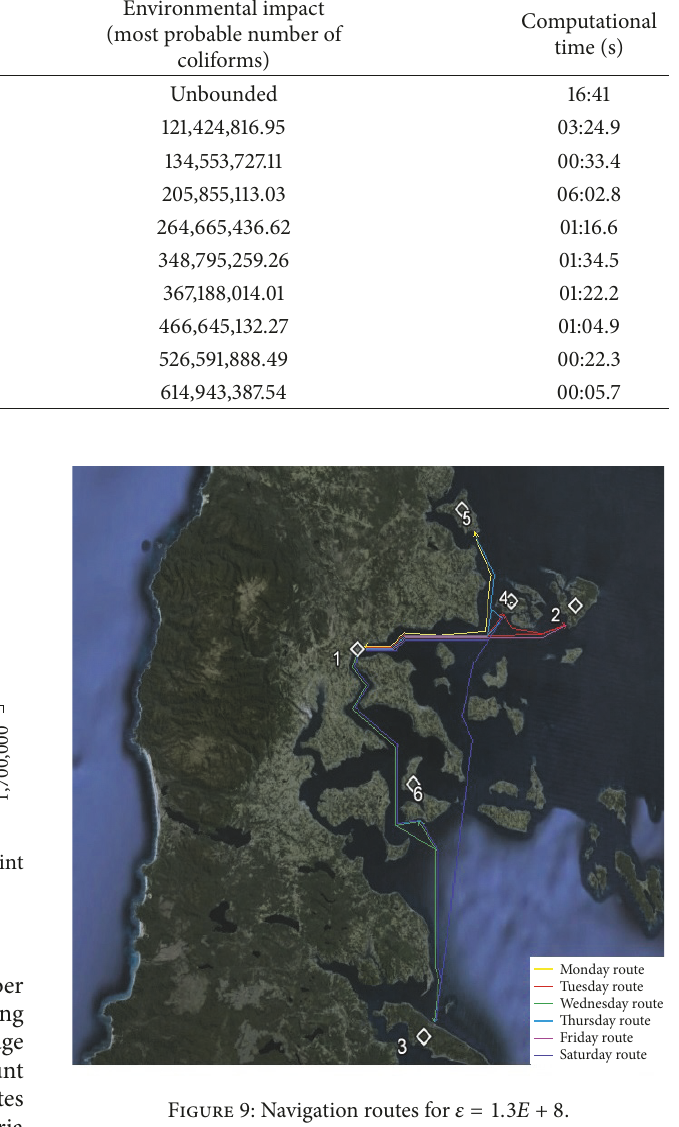
Figure 9: Navigation routes for 𝜀 = 1.3𝐸 + 8